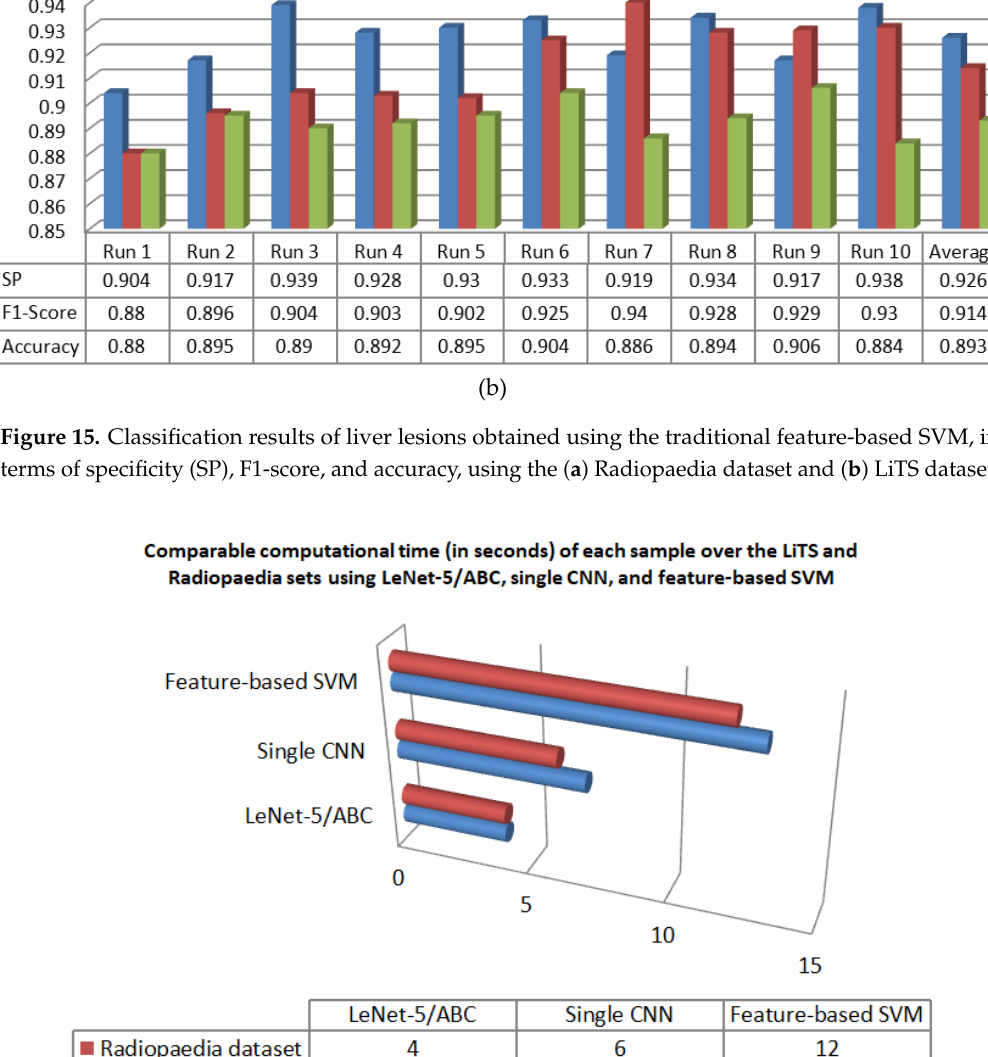
Figure 16. The computational time (in seconds) required by each CT image over the LiTS and Radiopaedia sets using LeNet-5/ABC, single CNN, and feature-based SVM.